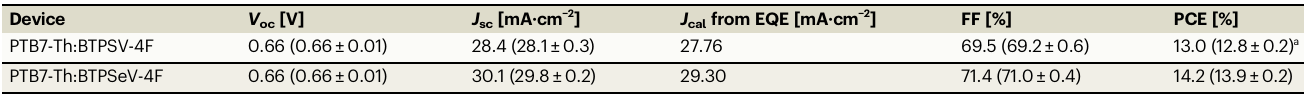
Table 1 | Photovoltaic parameters of the optimal single-junction OSCs based on PTB7-Th:BTPSV-4F and PTB7-Th:BTPSeV-4F, under the illumination of AM 1.5G, 100 mWcm − 2 Device